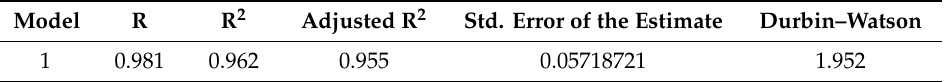
Table 1. Model summary.